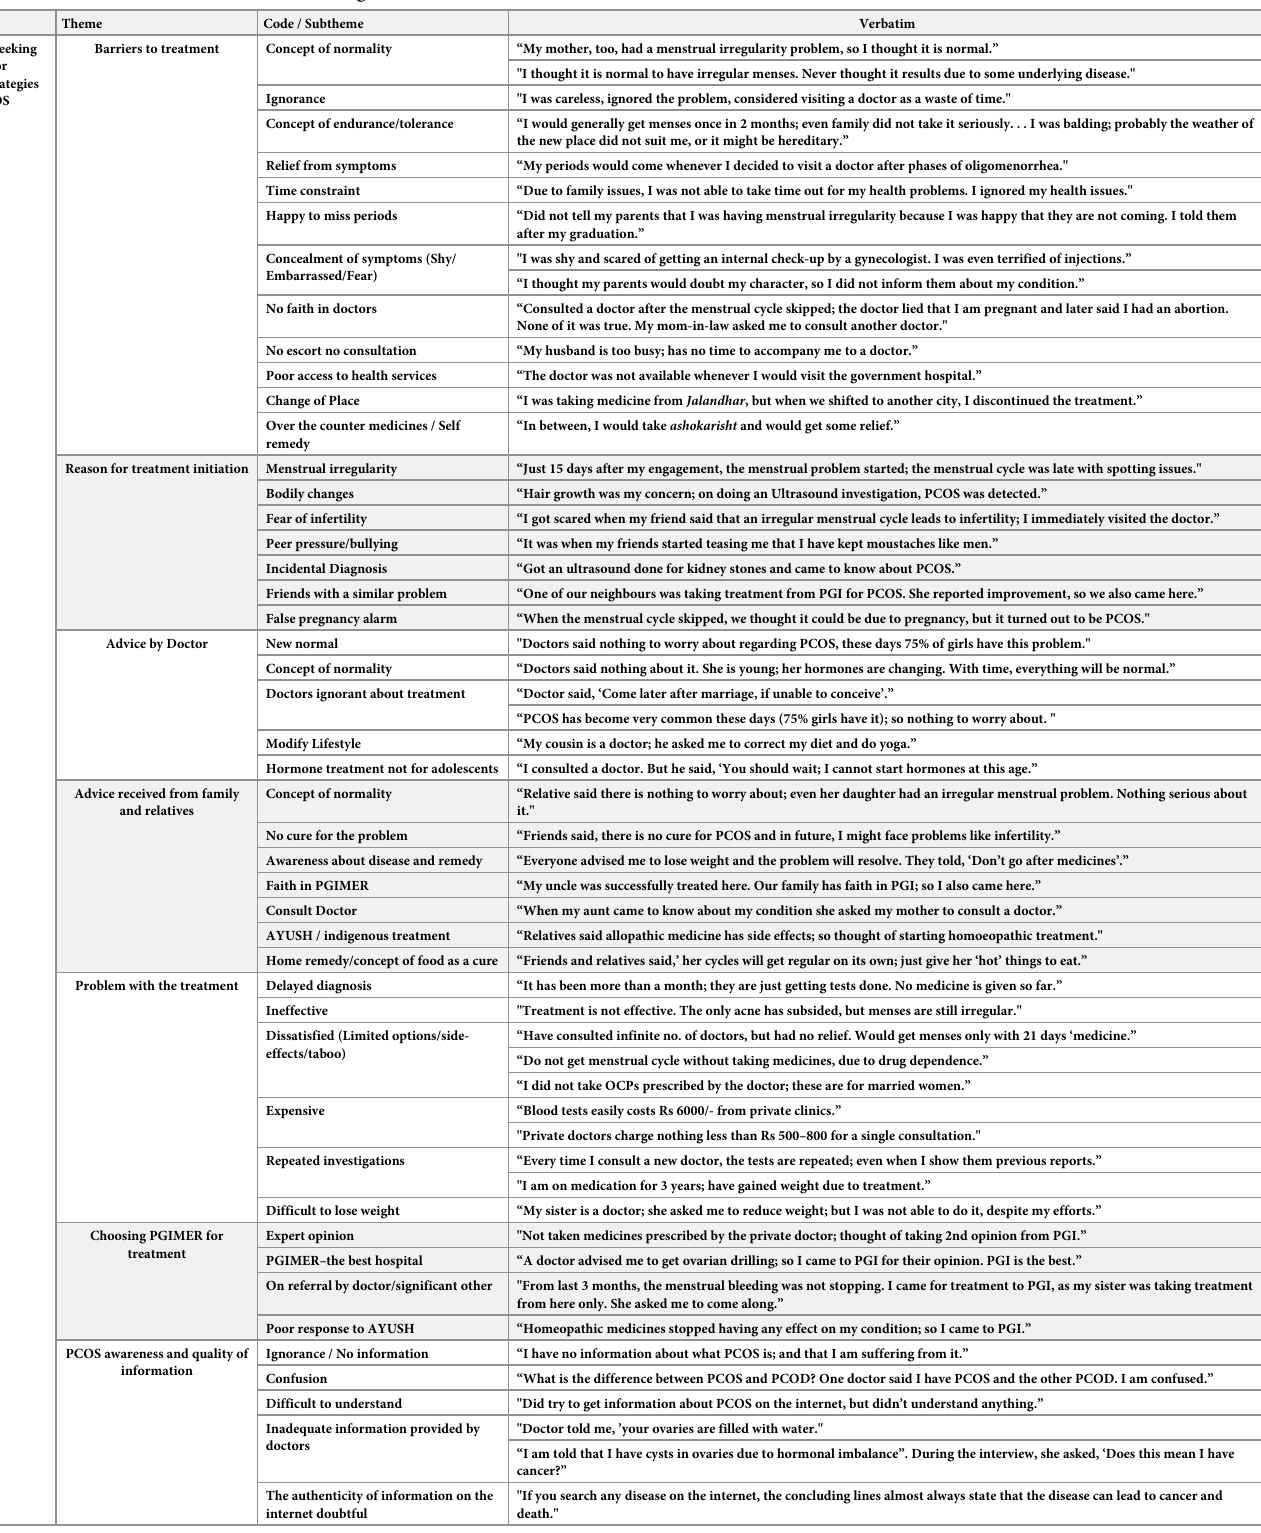
Table 2. Themes and sub-themes of treatment-seeking for PCOS. Title Theme behavior orcopingstrategies